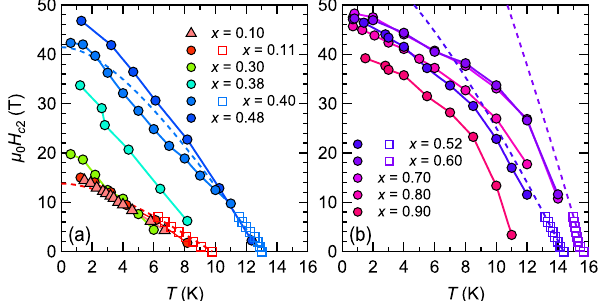
FIG. 2. Temperature dependence of the upper critical field H ð T Þ for the compositions (a) inside and in FeSe 1 − Te . (a),(b) H x x c 2 (b) outside of nematic phase determined from the TDO (triangles) and the resistance (circles) measurements under pulsed high magnetic fields. Solid lines represent the linear interpolation between each datum. Dashed lines show fits to the low-field data (open squares) measured under the steady field up to 7 T within the Helfand-Werthamer framework, which includes only the orbital pair-breaking effect. in FeSe 1 − Te . (a) – (c) Magneto- c 2 x x is defined as an c 2 is determined from the point c 2